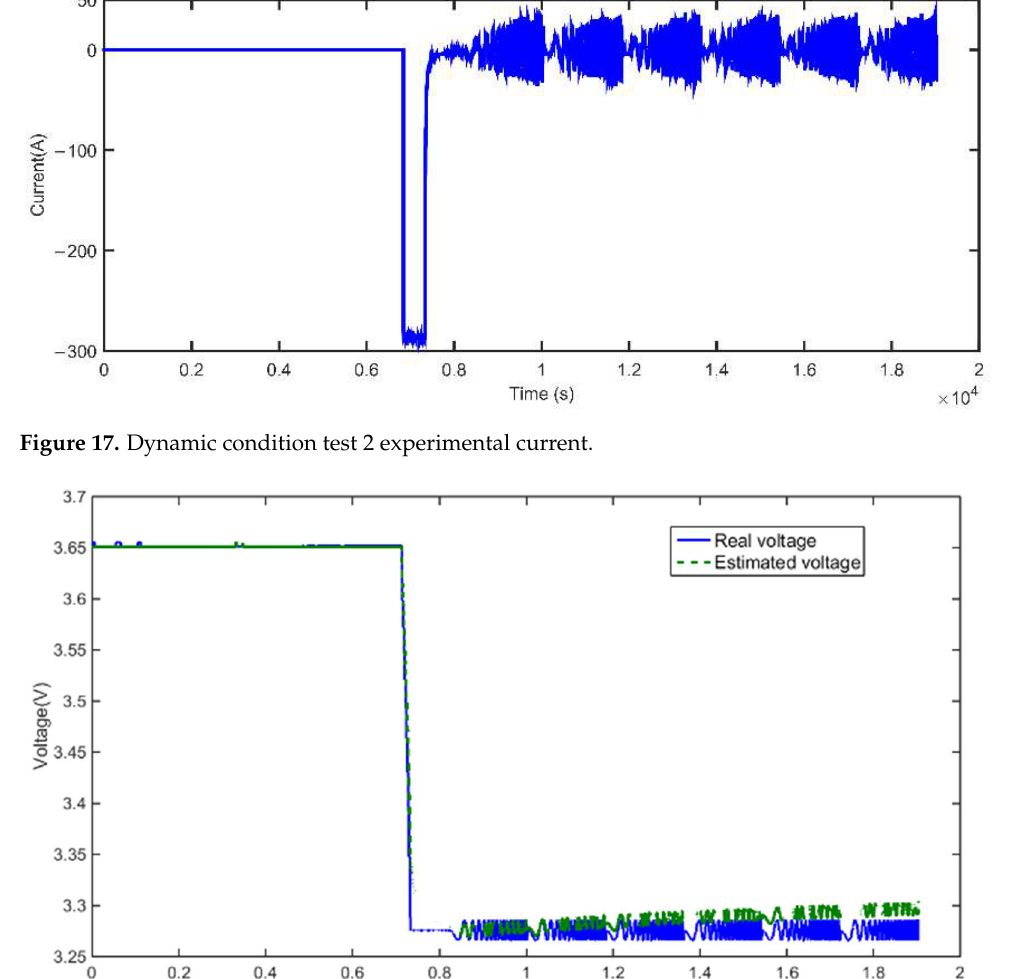
Figure 17. Dynamic condition test 2 experimental current.